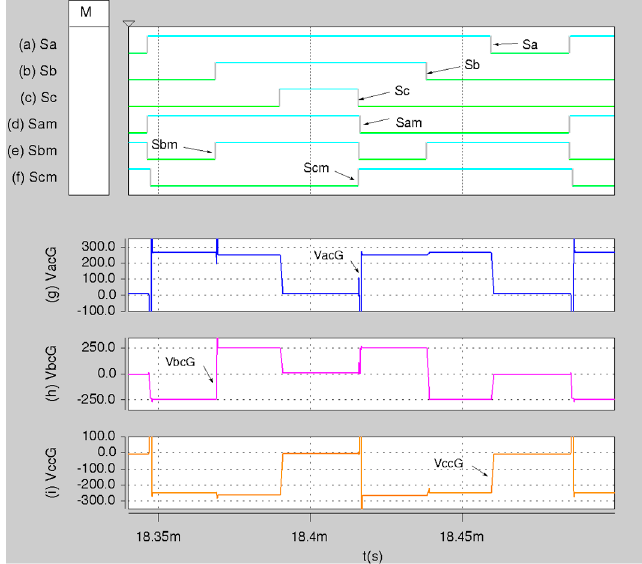
Figure 18. Simulations results: ( a ) conventional switching states S a ; ( b ) S b ; and ( c ) and S c ; ( d ) matrix converter switching states S am ; ( e ) S bm ; and ( f ) S cm ; ( g ) Voltage v acG ; ( h ) v bcG ; and ( i ) v ccG . Supply: 127 V, 60 Hz, Output: 100 V, 5 kW.